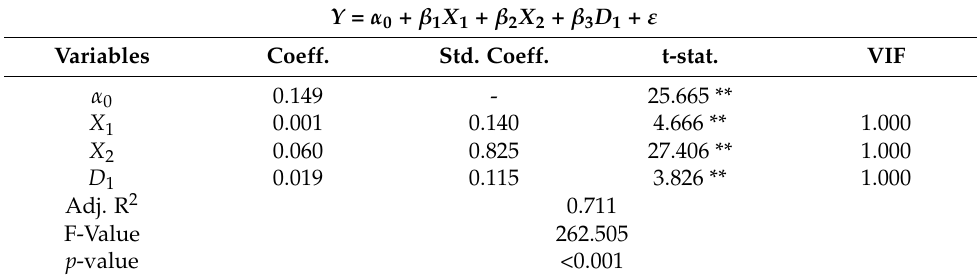
Table 2. Results of multi-regression